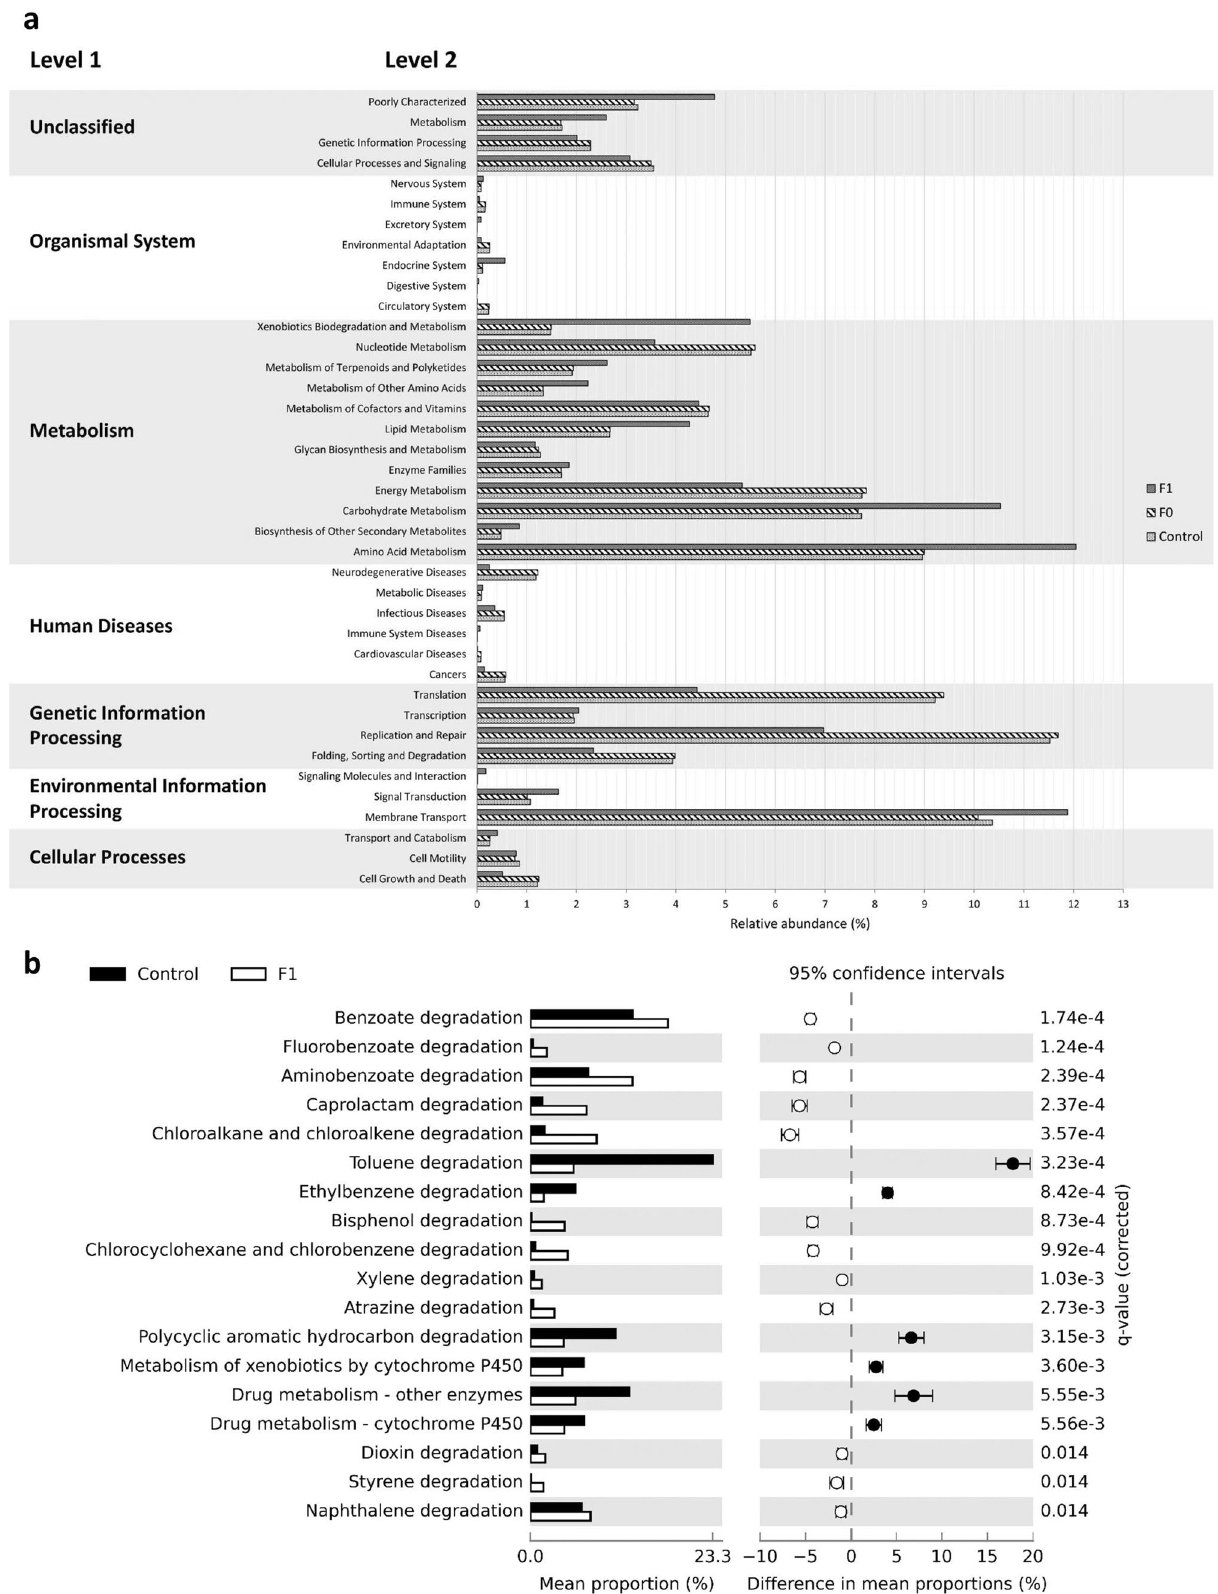
Figure 3. Functional prediction analysis generated by PICRUSt. ( a ) The relative abundance of the predicted functions grouped according to KEGG level 1 and 2 categories of the bacterial communities; ( b ) Extended error bar of predicted function subsystem of xenobiotics biodegradation and metabolism at KEGG level 3. The results were filtered using a Welch’s t-test (two groups comparison) with Benjamini–Hochberg FDR correction ( P -value < 0.05) in STAMP